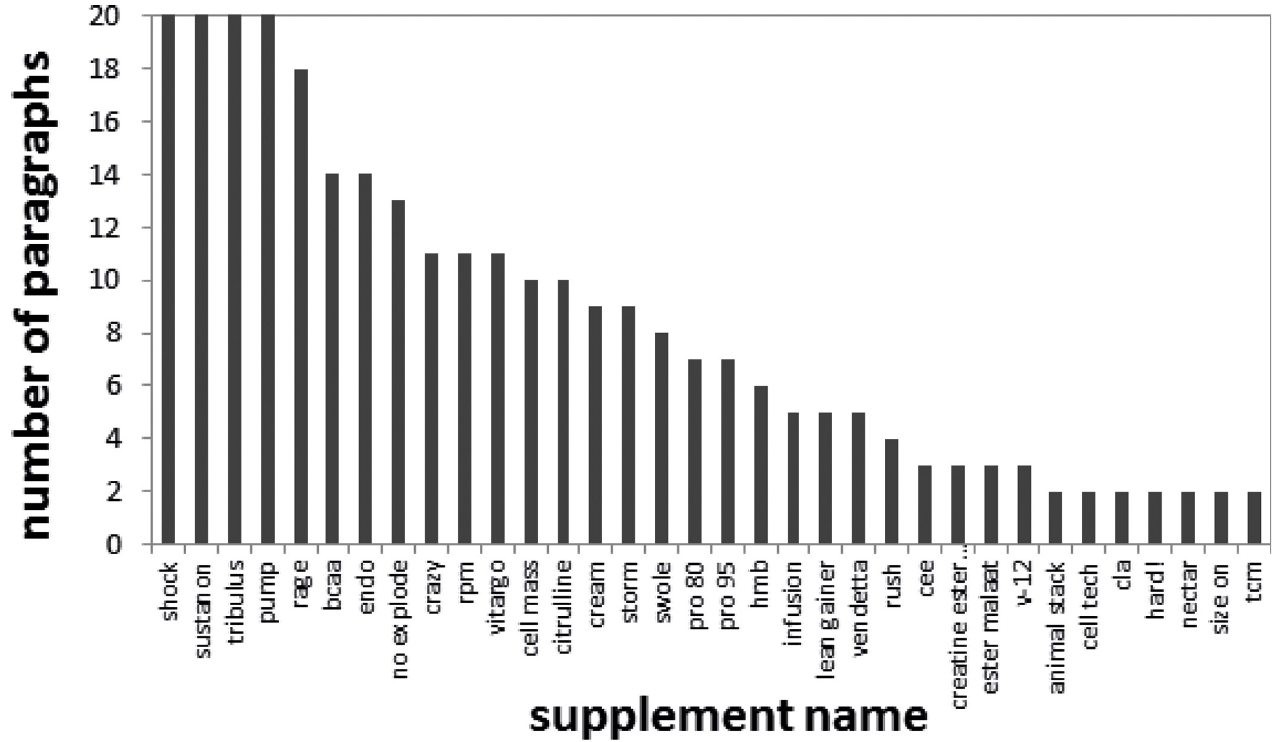
Fig 4. Results from searching the “Body-fitness” forum using Pinto, a products filter and an effects filter. The number of paragraphs in which the product was mentioned together with an effect was plotted per dietary supplement product name. A maximum of 20 paragraphs was plotted and only supplements with more than 1 hit were